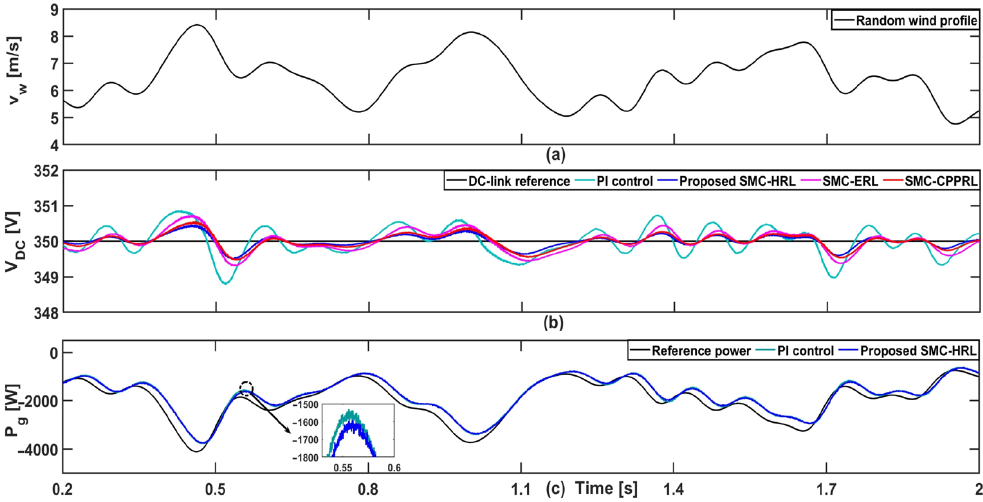
Figure 6. Simulation responses of DC-link voltage under random wind profile. ( a ) Wind speed. ( b ) DC-link voltage. ( c ) Grid-side active